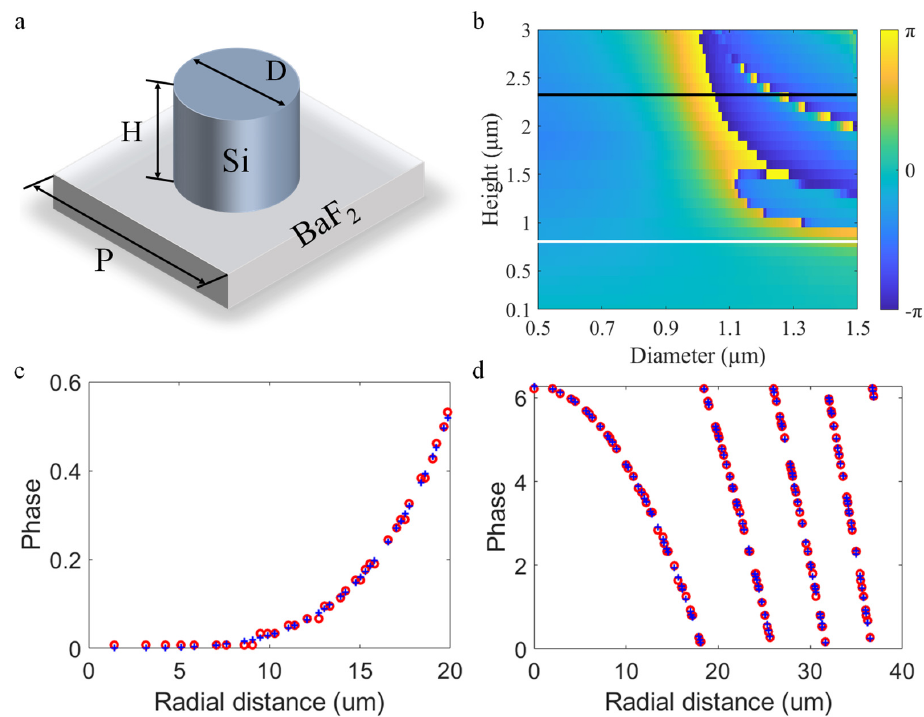
Figure 2. ( a ) Schematic diagram of micro − nano unit structure. ( b ) Simulated phase shift as a function of micro − nano pillar radius and height, the white and the black line represents the micro − nano structure height of the CL and the FL, respectively. ( c , d ) Ideal phase distribution of the CL and the FL, the blue plus and circle red markers represent the ideal and design phase,